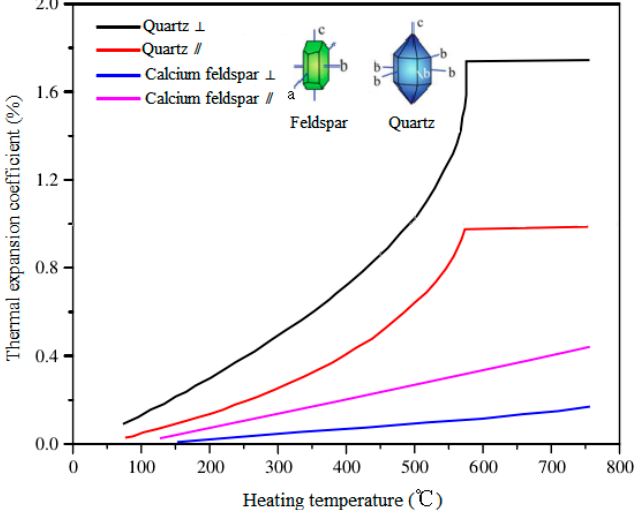
Figure 16. Variation of thermal expansion coefficient of quartz and calcium feldspar with heating temperature